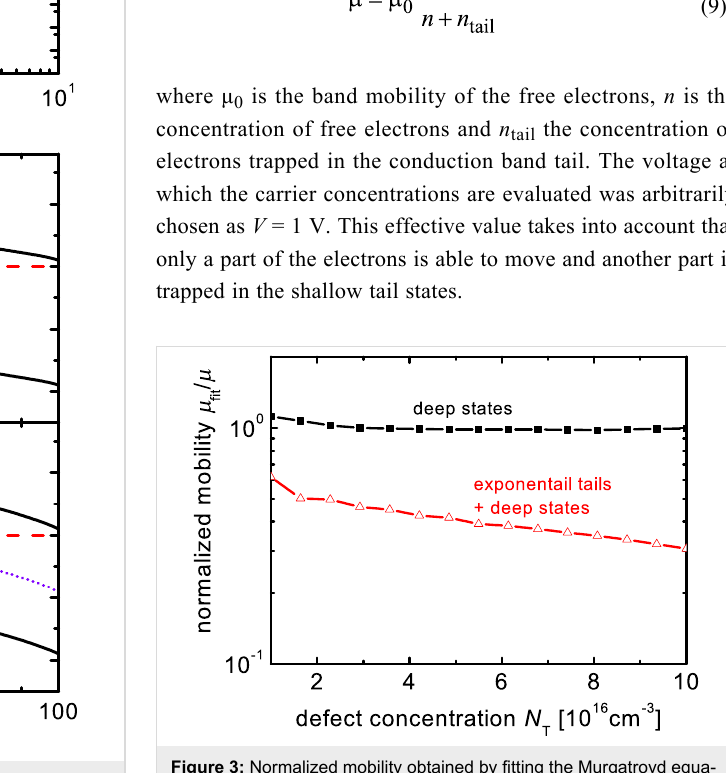
Figure 2: (a) Current–voltage curves of a device with charged acceptor-like defects and a built-in voltage V bi = 0 V (as in Figure 1a) and a device with no defects but a built-in voltage V bi = 1 V are compared to the Mott–Gurney law (Equation 1). Band diagram of the device (b) without charged defects and V bi = 1 V and (c) with charged defects and V bi = 0 V. Both band diagrams are depicted at short circuit.